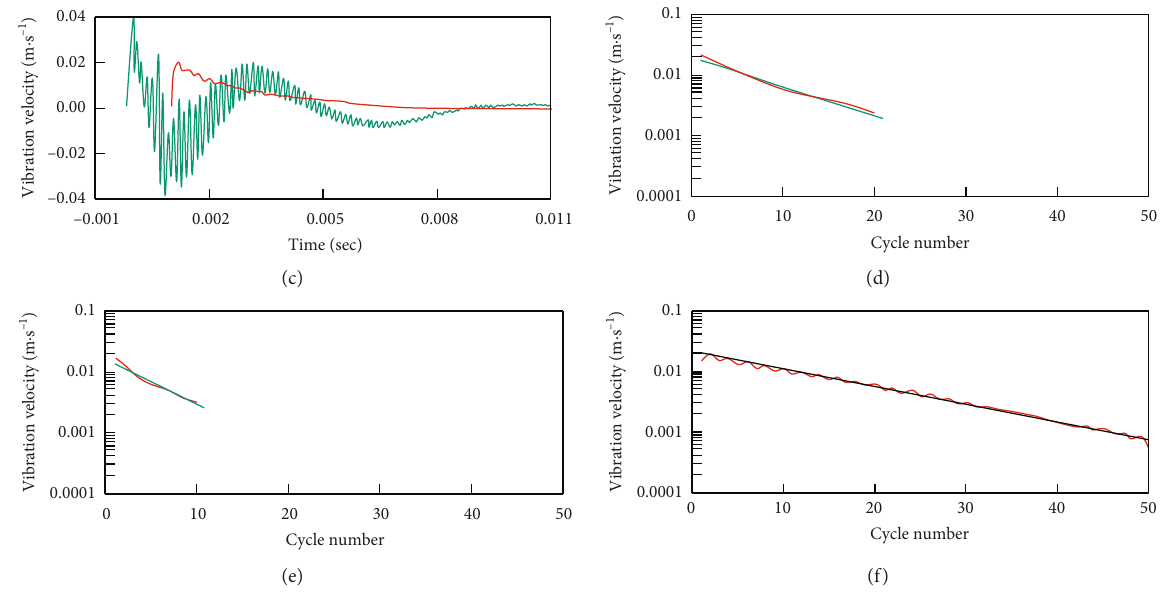
Figure 6: Temporal change (left panels) and logarithmic decay (right panels) of the vibration velocity of molded composites obtained by the HHP method from (a, d) CaCO 3 -chitosan composite prepared at 95 ° C; (b, e) CaCO 3 -chitosan composite prepared at 4 ° C; and (c, f) milled scallop shells. (a–f) The red lines were obtained by subtracting the slow sway from the envelope of the rapid sway, and (d–f) the blue lines are collinear approximations of the red lines. Table 2: Logarithmic decrement of molded composites obtained by means of the HHP method. CaCO 3 -chitosan composite prepared at 95 °